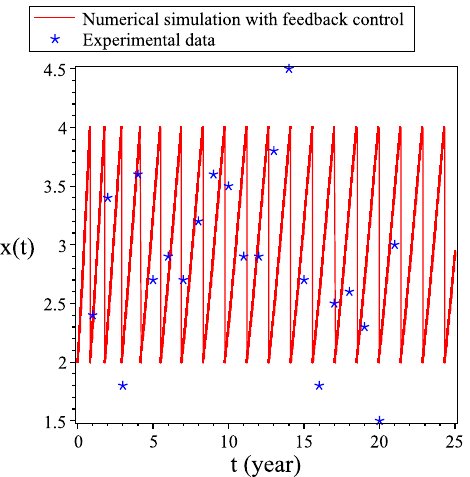
Figure 7. The parameter x denotes the density of pests. The red line denotes the sample path of pest species with continuous delay and feedback control and the blue star denotes the experimental data (the data comes from the Wanfang data knowledge service